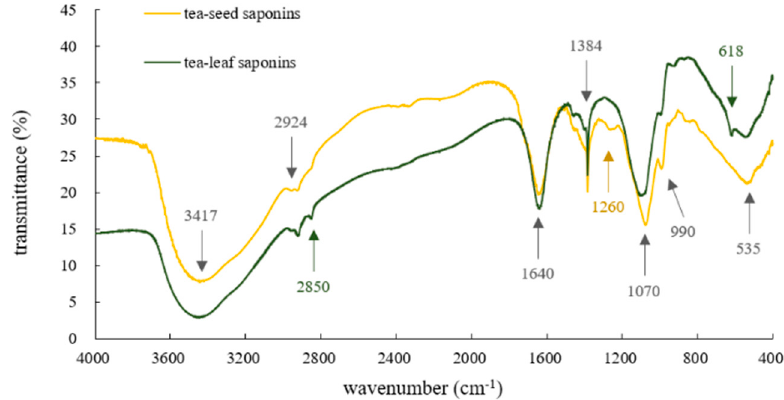
Figure 3. FT-IR spectra of tea-leaf saponins and tea-seed saponins. Wavenumbers are in yellow for tea-seed saponins, in green for tea-leaf saponins and in grey for